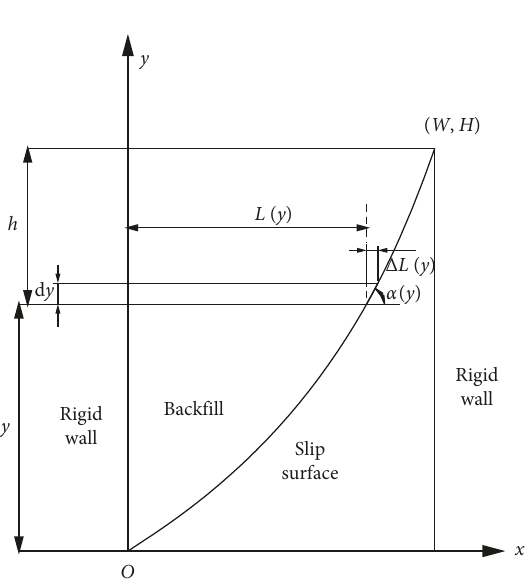
Figure 1: Geometric layout and coordinate